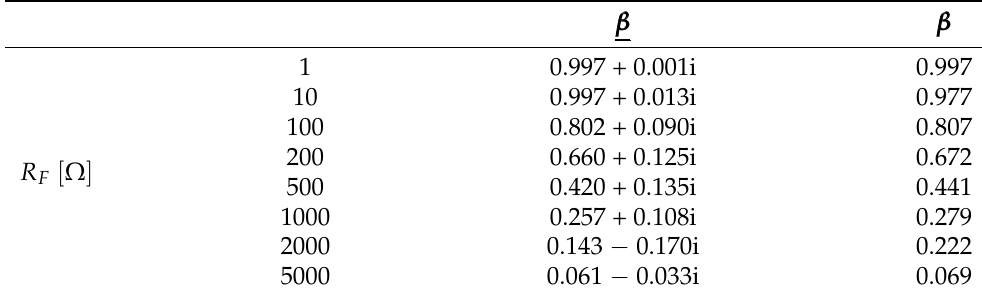
Table 2. Values of the earth fault coefficients and their modulus for various R F in the compensated MV network.